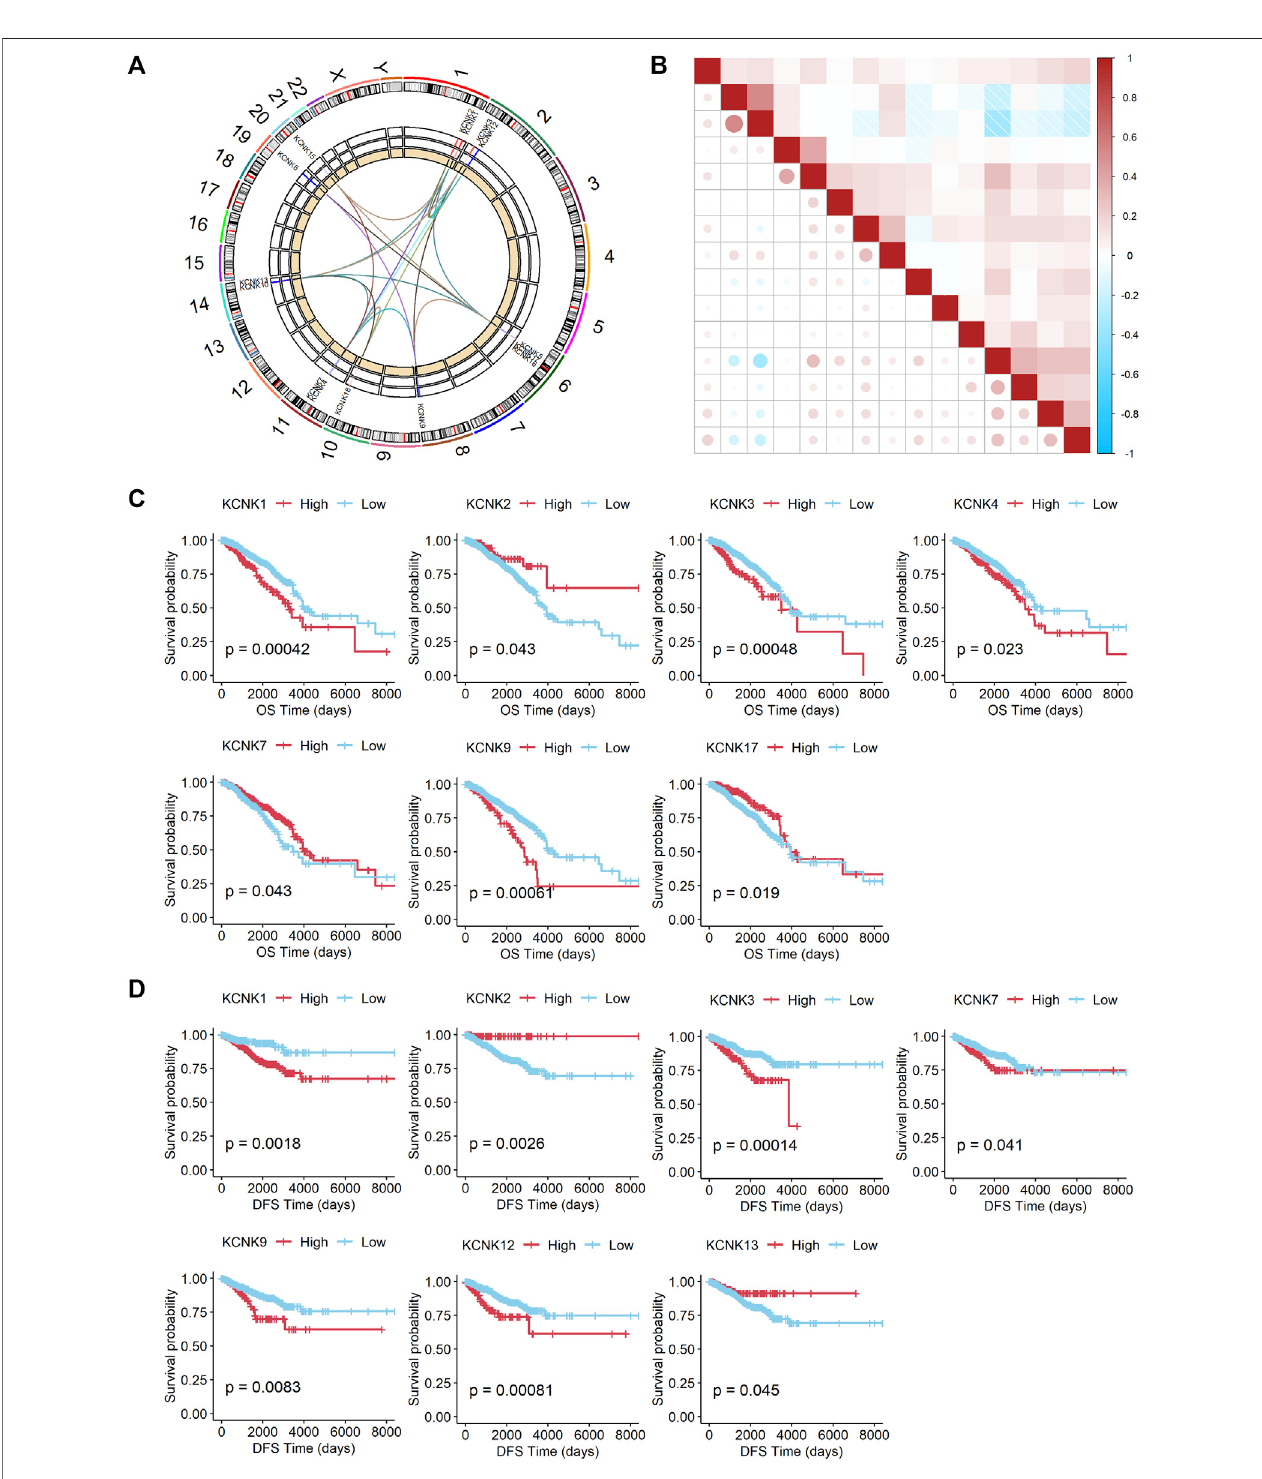
FIGURE4 | Prognostic value oftheexpression ofKCNK genefamily inbreast cancer. (A) Circos plotdisplayingthe position ofKCNK geneson chromosomes. (B) ThecorrelationofeachKCNKgeneaccordingtotheTCGAdatabase. (C) K-Manalysisoftheoverallsurvival(OS)ofbreastcancerpatientswithhighorlowexpressionof each KCNK gene according to the TCGA database. (D) K-M analysis of the disease-free survival (DFS) of breast cancer patients with high or low expression of each KCNK gene according to the TCGA database.